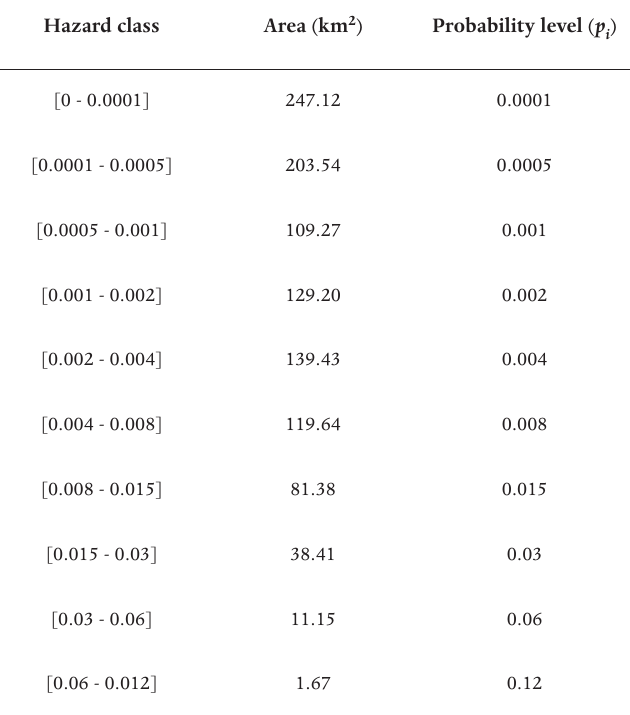
Table 2. Probabilities and areas of the ten hazard intervals into which the lava-flow invasion hazard map was